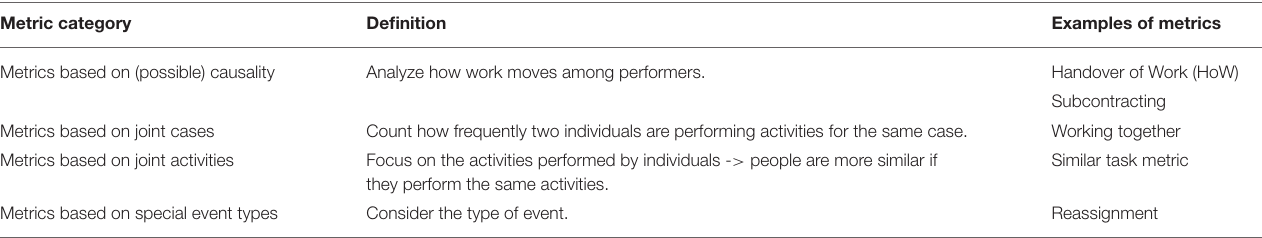
TABLE 2 | Types of social network metrics used for analyzing relationships from event